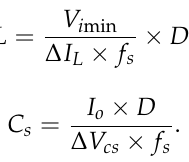
i L2 Figure 6. Configuration of a single ended primary inductance converter (SEPIC) converter.